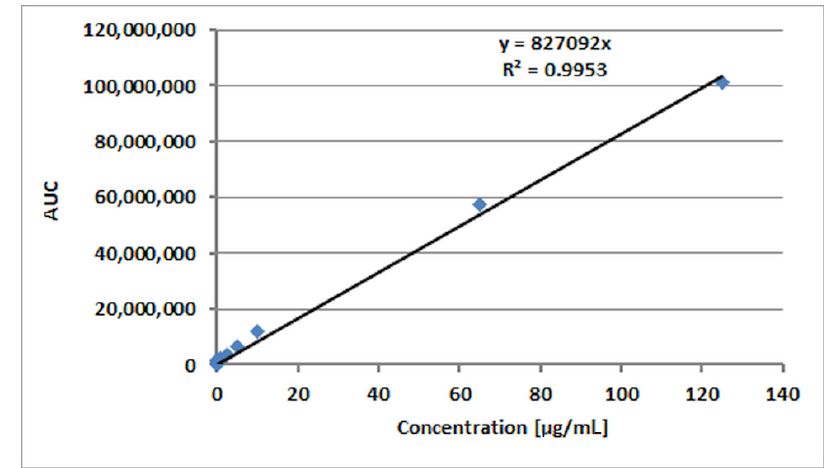
Figure 1. High-performance liquid chromatography (HPLC) calibration curve for p-anisic